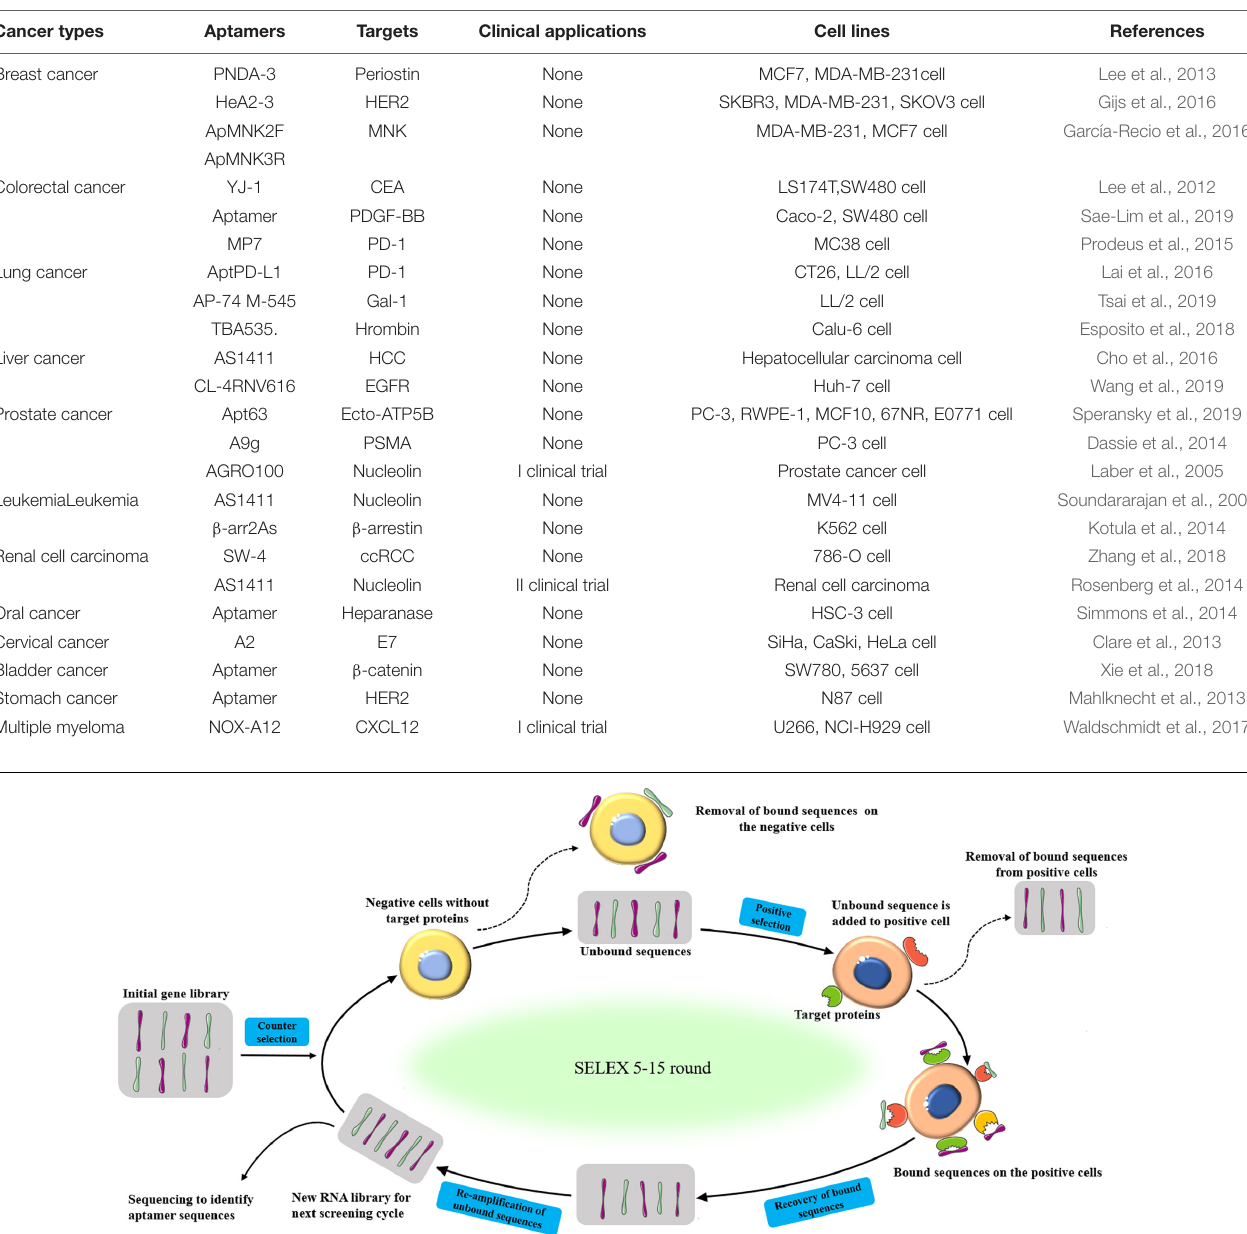
TABLE 2 | Examples of aptamers with potential as targeted drugs.